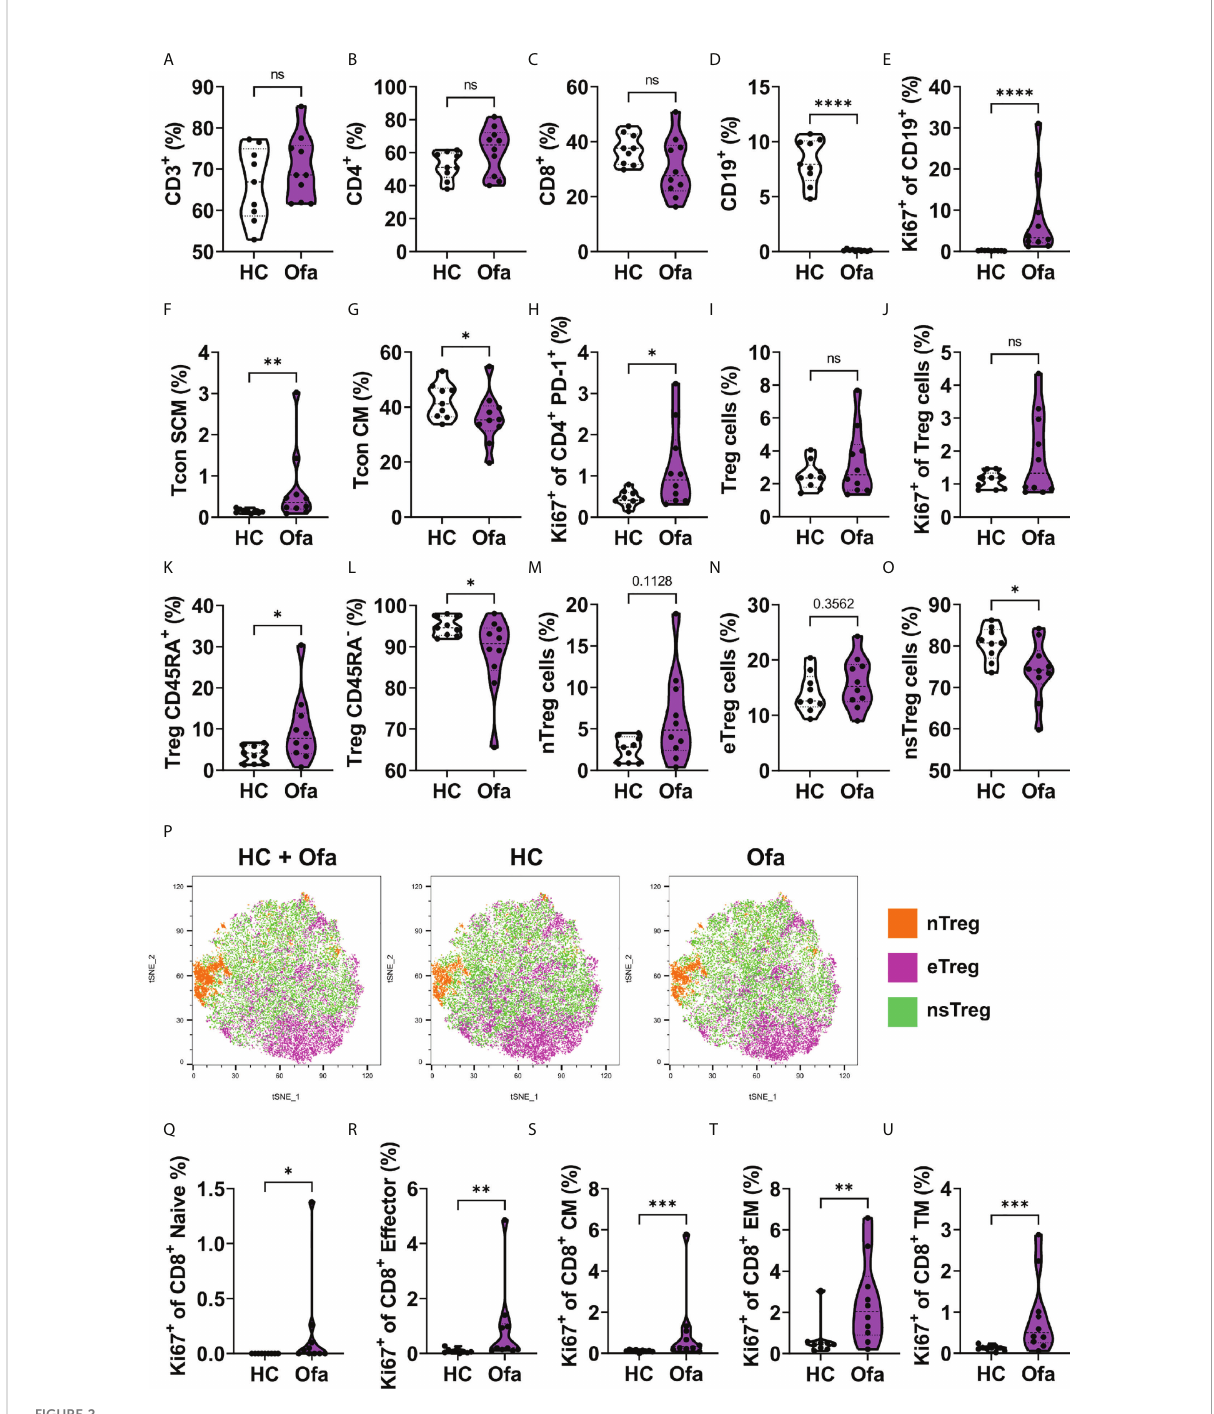
FIGURE 2 Lymphocyte composition in ofatumumab treated MS patients and healthy controls. Immunophenotyping was conducted in Ofa and HC using multi-color FACS. (A-D) T cell frequencies showed no difference between Ofa and HC but a tendency towards higher frequencies of T helper cells and less cytotoxic T cells in the Ofa group. (D, E) Ofa patients had signi fi cantly lower frequencies of B cells with near complete depletion (p<0.0001) compared to HC with higher proliferation of remaining B cells as shown with higher expression of Ki67 (p<0.0001). (F-O) T helper cell subpopulation analyses with speci fi c focus on regulatory T cells (Tregs) including unsupervised clustering of the Treg populations (P) . (Q-U) proliferation of cytotoxic T cell subpopulations was signi fi cantly higher in the Ofa group. Tcon SCM: stem cell like memory T conventional cells. Tcon CM: central memory T conventional cells. Treg: T regulatory. nTreg cells: naïve regulatory T cells. eTreg cells: effector regulatory T cells. nsTreg cells: non-supressive regulatory T cells. TM: transitional memory cells. Data were analyzed with a two-tailed Mann-Whitney U test. n=10 Ofa, n=9 HC. *p<0.05; **p<0.01; ***p<0.001; ****p<0.0001, ns, not signi fi